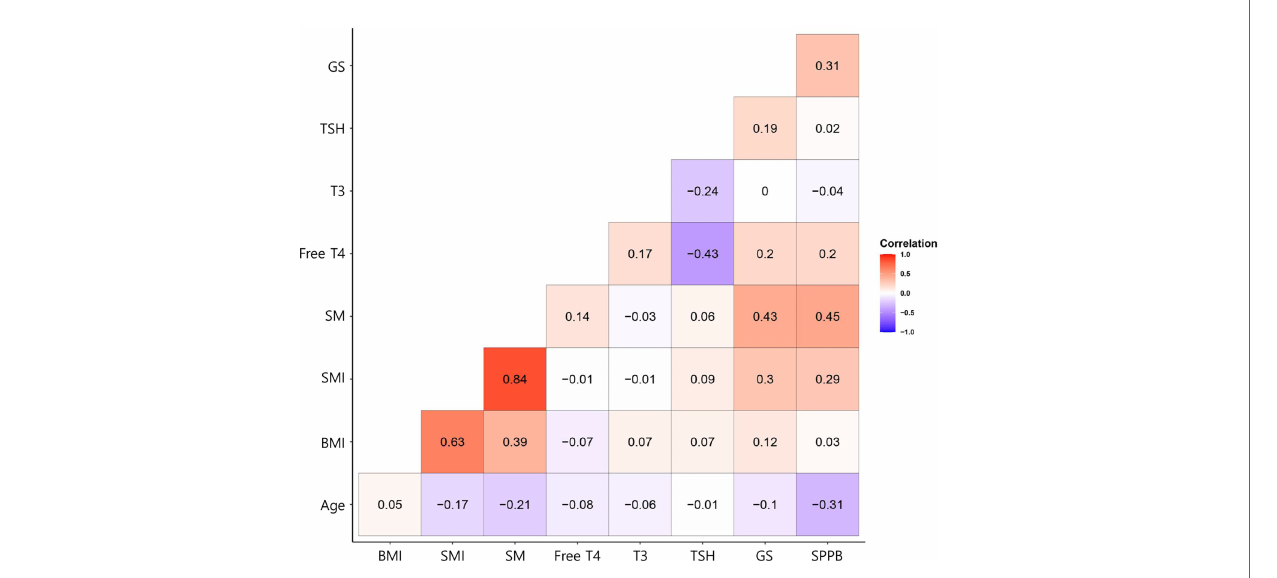
FIGURE 3 | Correlation coef fi cients for the relationships between explanatory variables and the response variable for the participants with thyroid cancer. In the corrgram, the depth of shading at the correlation matrices indicates the magnitude of the correlation. Positive and negative correlations are represented in red and blue, respectively.